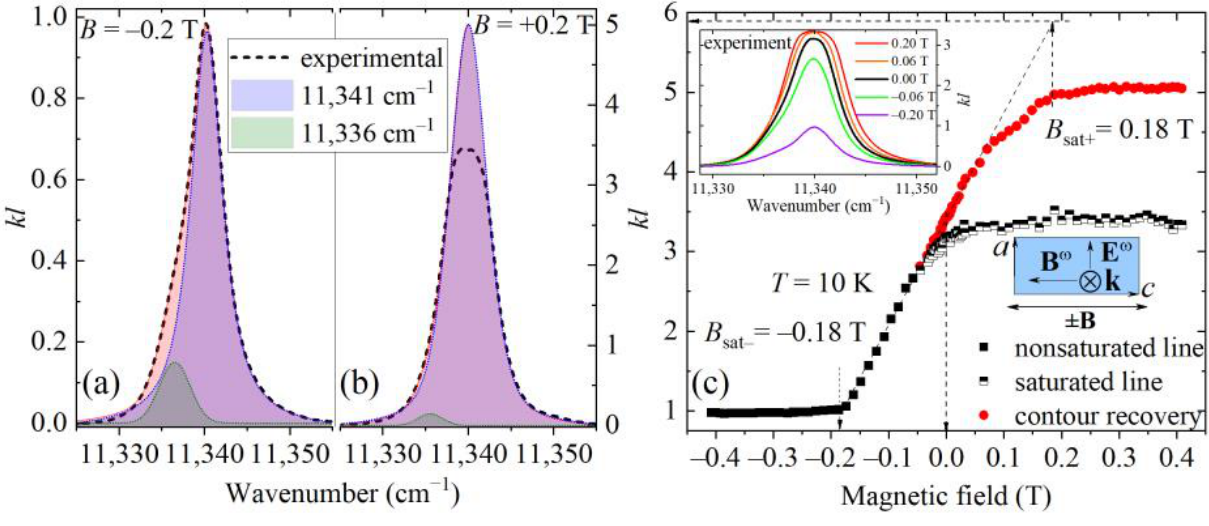
Figure 6. ( a ) Modeling of the line shape by a sum of two Voigt profiles and ( b ) reconstruction of the true shape of a strong line ( kl > 3.0, see the text). ( c ) The field dependence of the absorbance kl at the maximum of the component 11,341 cm −1 in the B ∥ c , k ∥ b , E ω ∥ a Voigt geometry. In the area of positive magnetic field values, the data with (red symbols) and without (black and white symbols) the contour-reconstruction procedure is presented. Inset shows the experimental profiles for different field values. Table 2. Experimental (cm −1 ) and theoretical (squares of matrix element moduli in relative units) values of the absorption coefficients at the maxima of two components of the lowest-frequency 4 b exciton line in the spectra of CuB 2 O 4 at T = 10 K in an external magnetic field | B | = 0.2 T. The rela- tive units are chosen so that in the Faraday geometry for the 11,341 cm − 1 component at 𝐁 ⇈ [010] , , 𝐋 = 𝐒 − 𝐒 ∥ [100] , 𝐄 𝜔 ⇈ [100] , 𝐁 𝜔 ⇈ [001̅] the calculated value is numerically equal to the 𝐴1 𝐴2 experimental